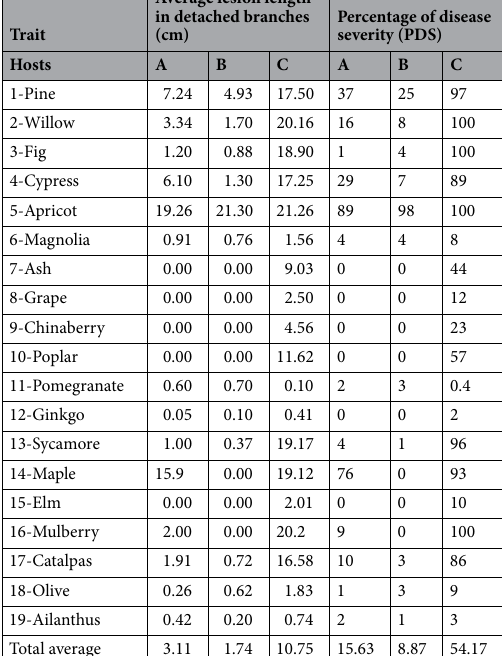
Table 3. The results of three regimes (A, B, and C) were the significant effects of high temperature and low humidity for detached branches in 19 hosts. In C regime, the pathogen affected all samples. It changed the inoculated tissues to brownish